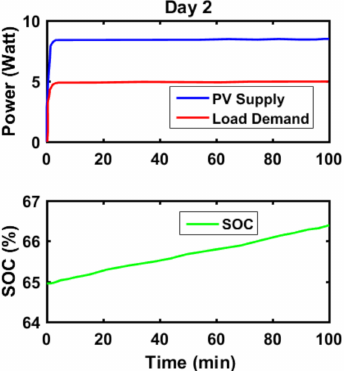
Figure 9. Experimental analysis for Day 2: 540 W / m 2 , 27 ◦